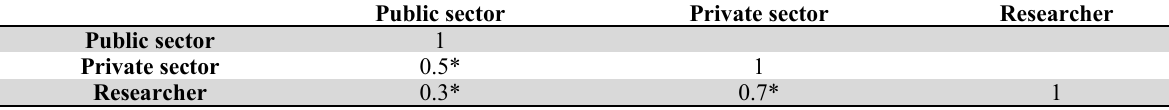
Correlation among Category of Respondents on VFM factors